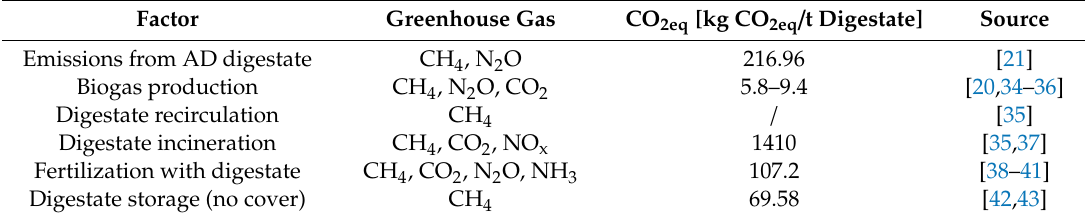
Table 3. Parameters specific for digestate treatment